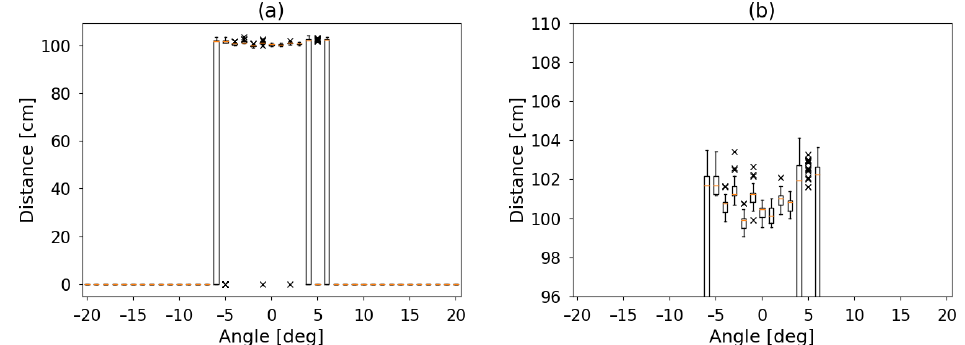
Figure 7. Measurement results for a cylinder one meter height, 75 mm diameter located one meter from the sensor. For steps of 1 degree, 100 measurements were acquired each. ( a ) In the left panel, the box plot of the data is in full range. ( b ) In hte right panel, details of the values where a detection was performed. The bottom line of each box indicates the first quartile. The box itself is the second and third divided by an horizontal line (the median). The top line is the fourth quartile. Outliers are plotted as individual points with a cross. The obstacle is detected from − 6 to +6 degrees with a dispersion of 4